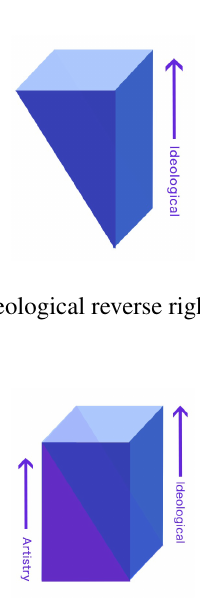
Fig. 3 Mathematical model of artistry and ideology in visual communication.